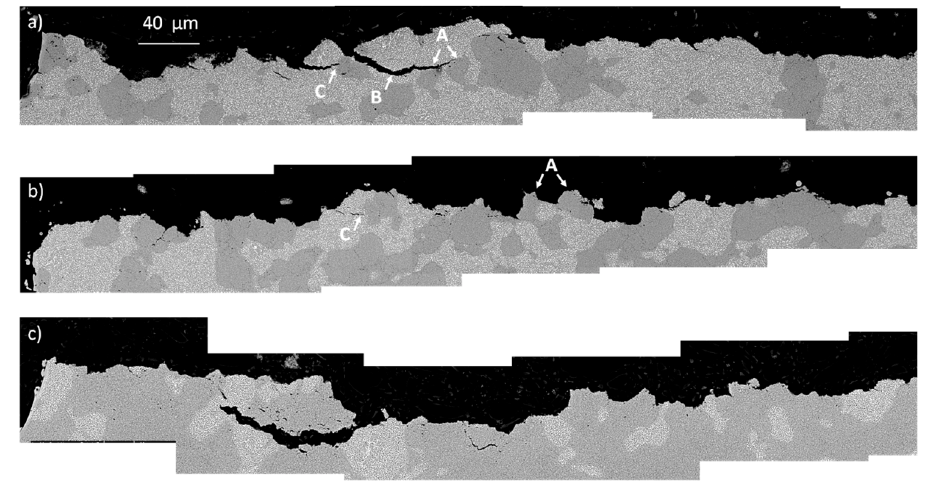
Figure 13. Cross sectional view of the fracture surfaces of ( a ) MM-20H13; ( b ) MM-40H13 and ( c ) MM-60% H13.